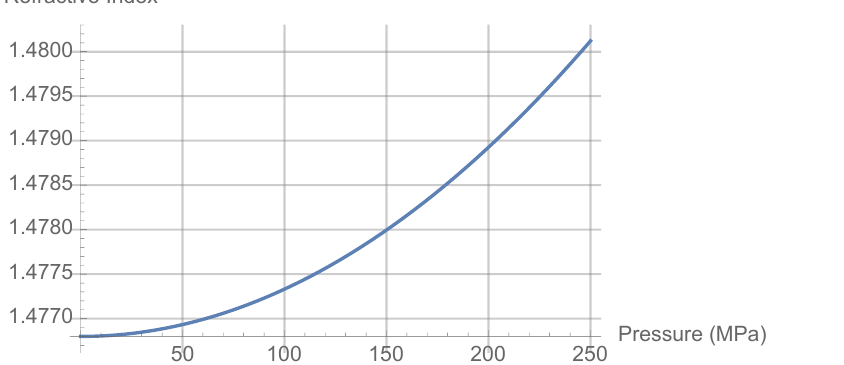
Figure A1. A plot of (8). See text for details. At 200 MPa the refractive index is 1.4784.